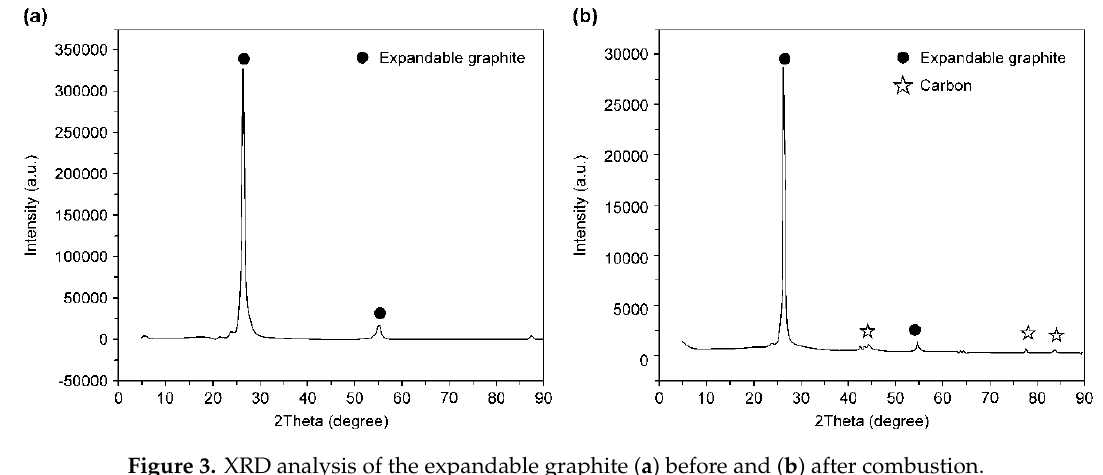
Figure 3. XRD analysis of the expandable graphite ( a ) before and ( b ) after combustion.